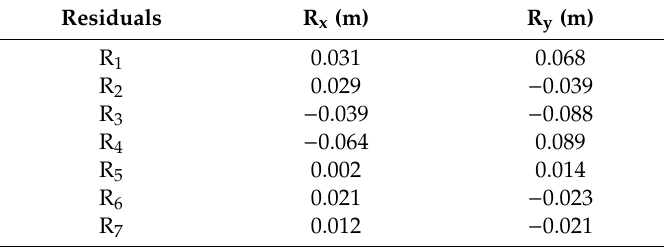
Table A4. Residual values of bilinear transformation.